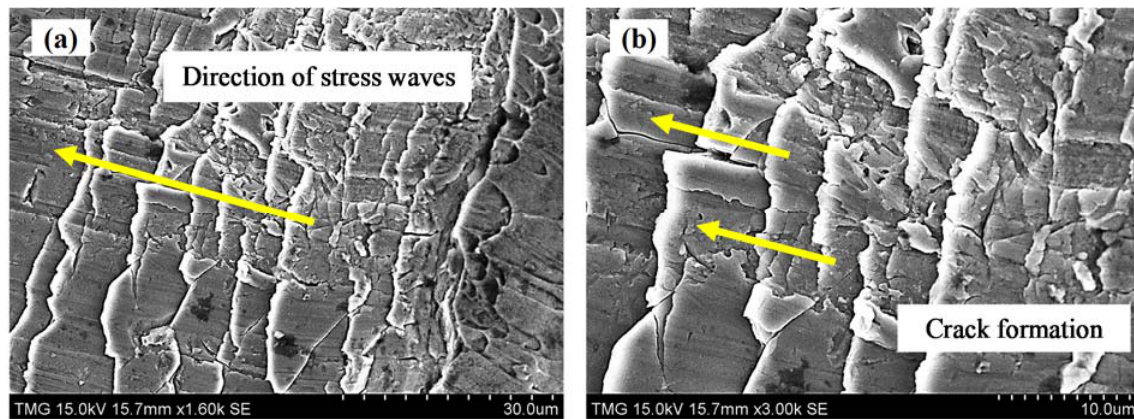
Figure 22. SEM micrograph shows plastic deformation of the non-treated Ti64 surface.